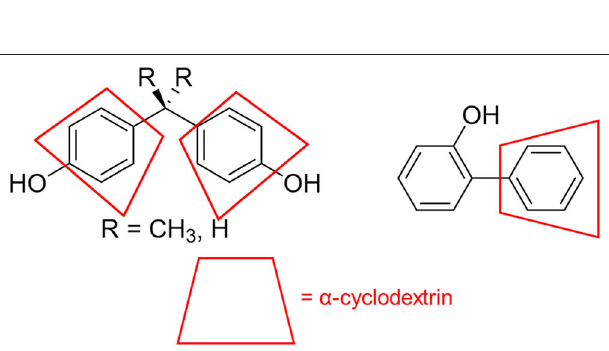
FIGURE 5 | Illustration of the products formed from chlorine dioxide-mediated decomposition of analyte 3 .